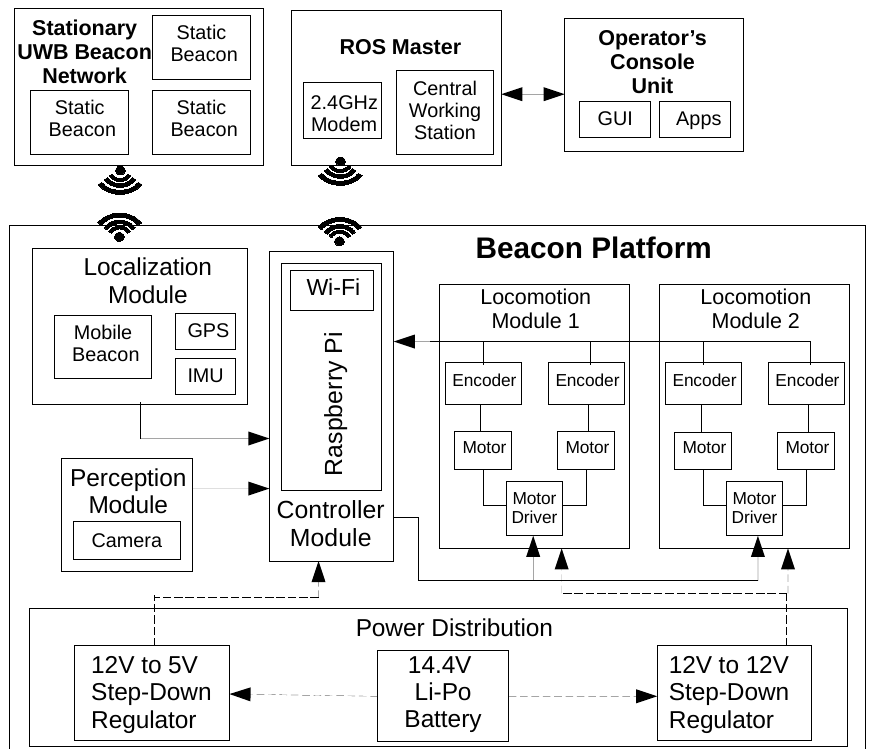
Figure 2. The control architecture of the Raptor